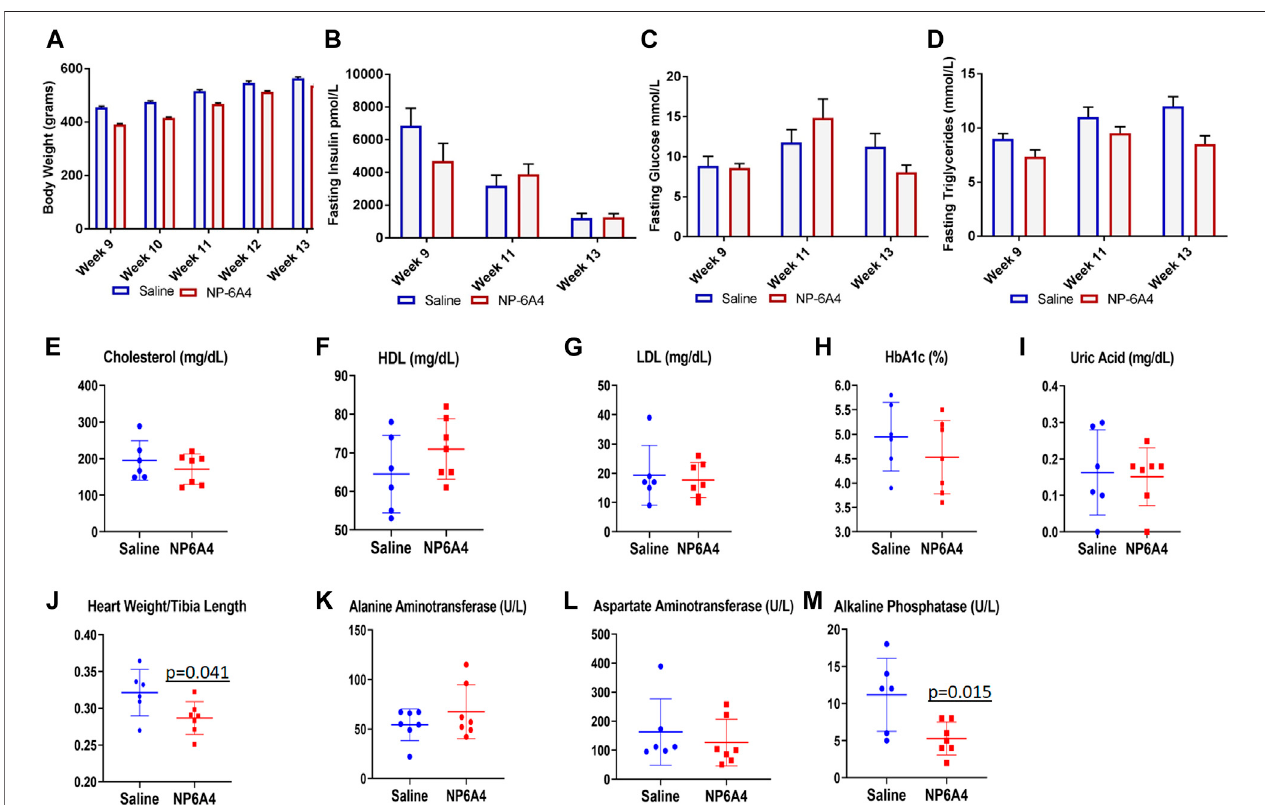
FIGURE 2 | NP-6A4 treatment did not change levels of fasting plasma glucose, insulin, lipids, and aminotransferases, but reduced heart weight and alkaline phosphatase signi fi cantly. N (cid:1) 6 for saline group and seven for NP-6A4 group. Heart weight (grams)/tibia length (cm) and plasma levels of alkaline phosphatase (U/L) at the end of treatment were signi fi cantly reduced ( p values are marked). None of the other parameters showed any signi fi cant